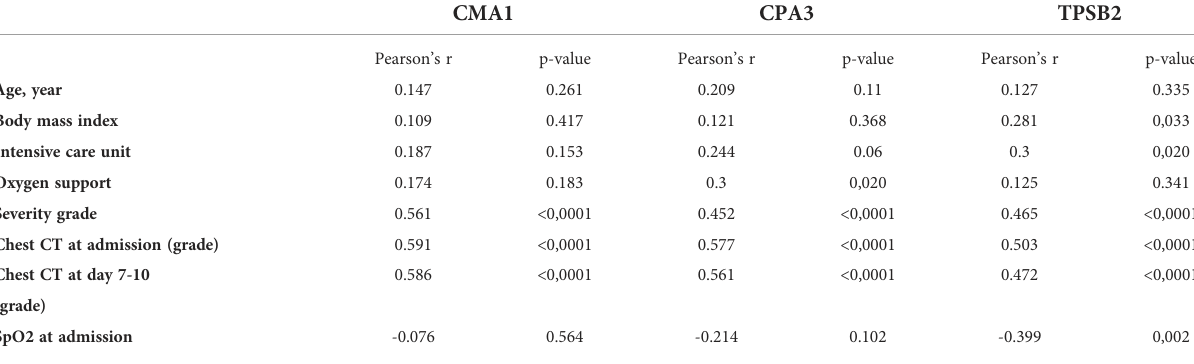
TABLE 2 Correlation analysis of MC protease levels in serum with demographical and clinical characteristics of patients with